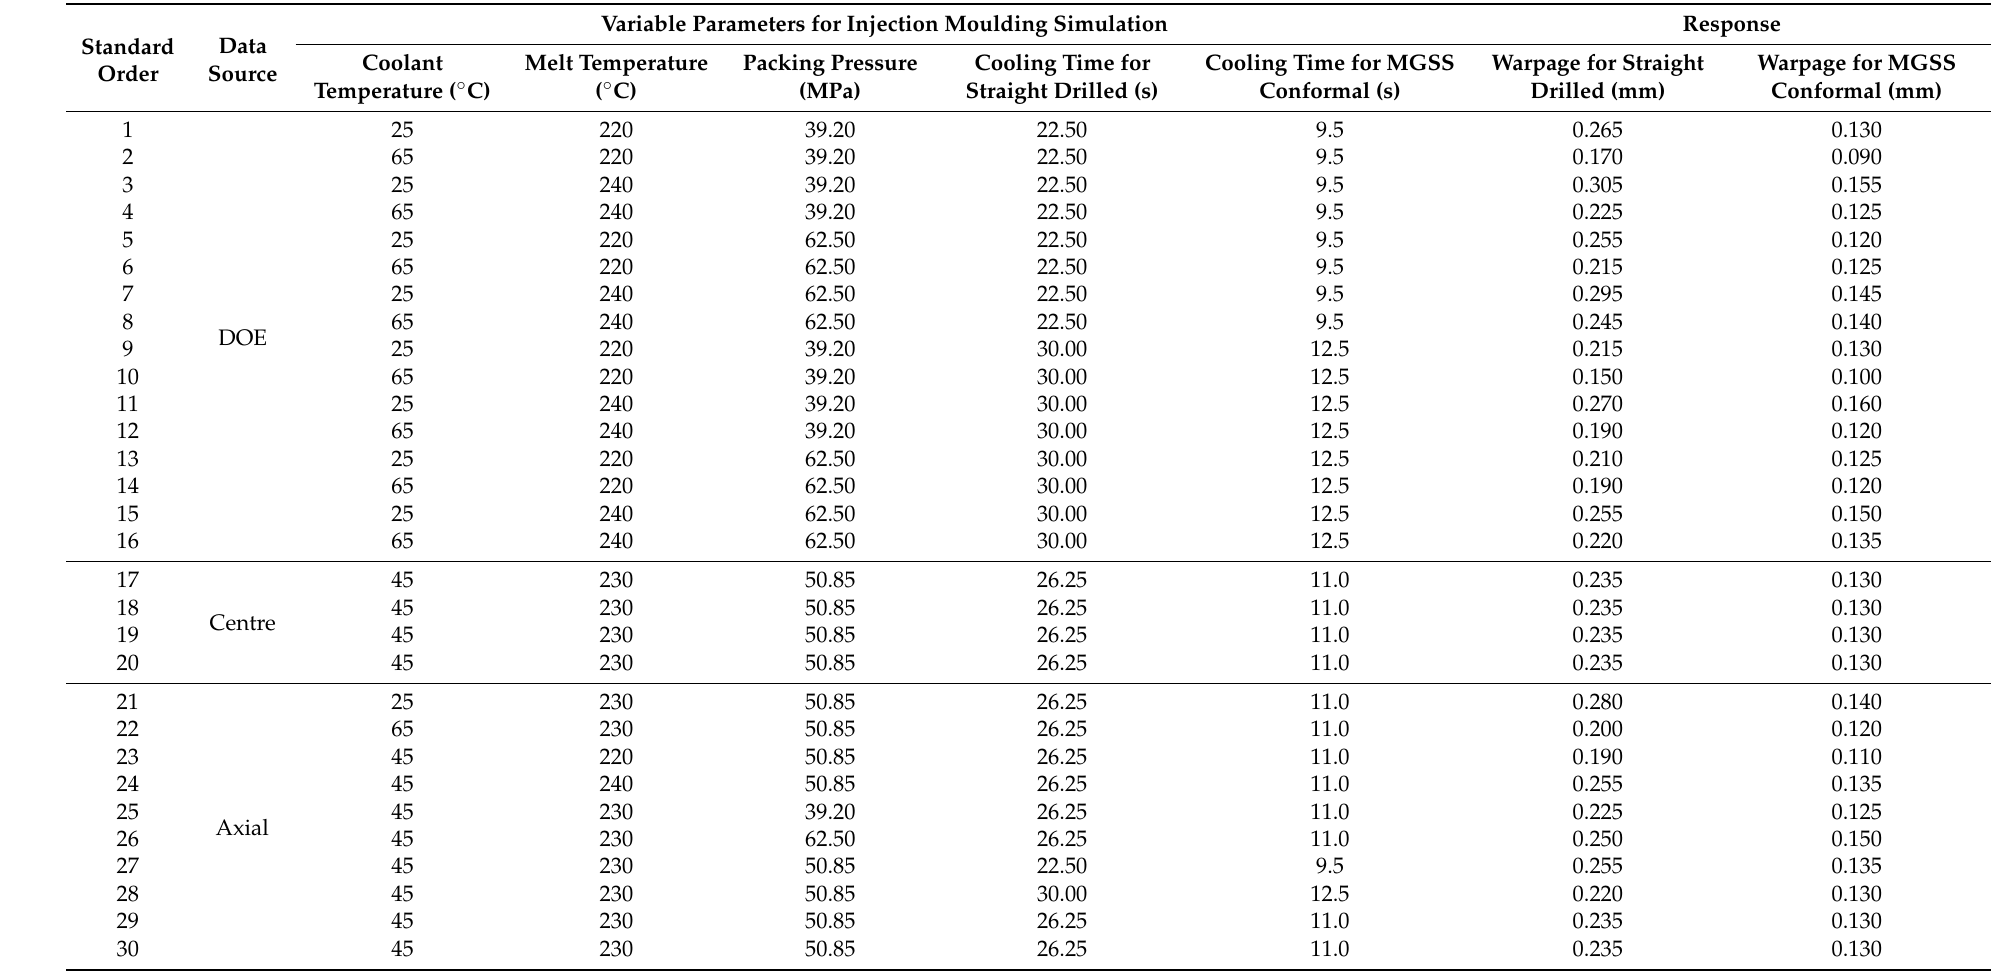
Table 3. Design of experiment (DOE) results for straight drilled and MGSS conformal cooling